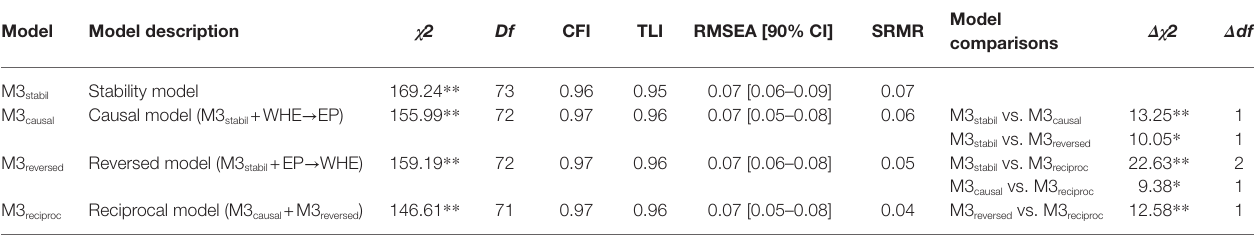
TABLE 5 | Fit statistics for the cross-lagged structural models between work–home enrichment and entrepreneurial performance. Model Model description